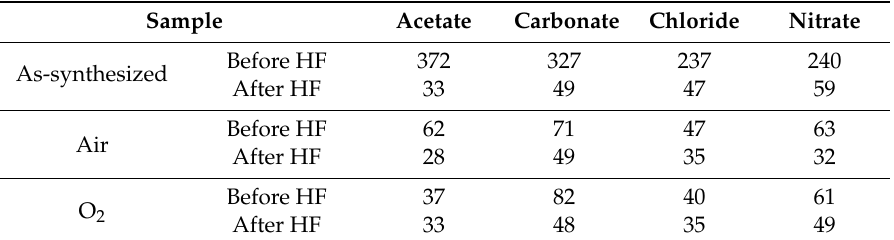
Table 3. Impacts of the magnesium precursors (acetate, carbonate, chloride, nitrate) and of the treatments (air, O 2 ) on the specific surface areas (S BET , m 2 · g − 1 ) of the MgF 2 samples, before and after HF activation.